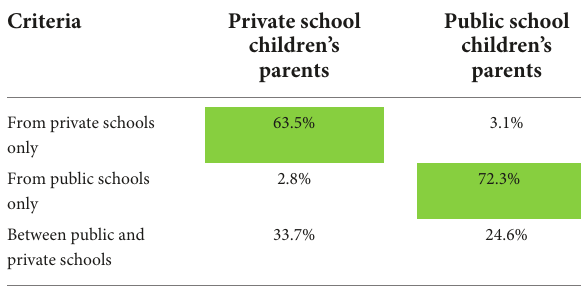
TABLE 4 School selection criteria; 600 respondents, SE